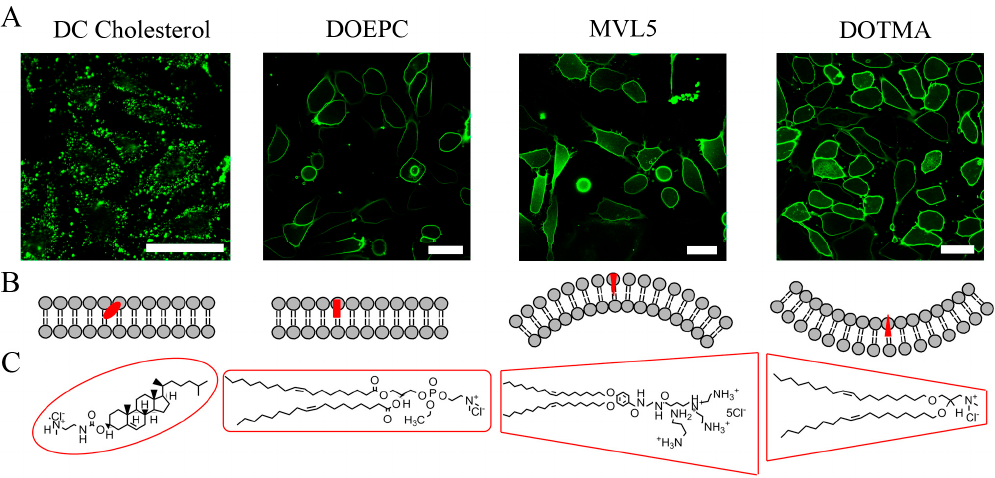
Figure 2. ( A ) Liposomal zeta potential (blue triangles) and fusion efficiency (black squares) at varying cationic lipid concentration. Bar indicate standard deviations. ( B ) Flow cytometry dot plots to determine the cellular uptake pathway and its efficiency. Liposomes always contained the aromatic tracer BODIPY FL-DHPE. Its monomer signal was detected in the green, its dimer signal in the red channels after incubation with Chinese hamster ovary cells (CHO). Endocytotic liposomal uptake resulted in a nearly equal dimer and monomer signals of the tracer, while a high monomer and a low dimer signal were detected in the case of membrane fusion.